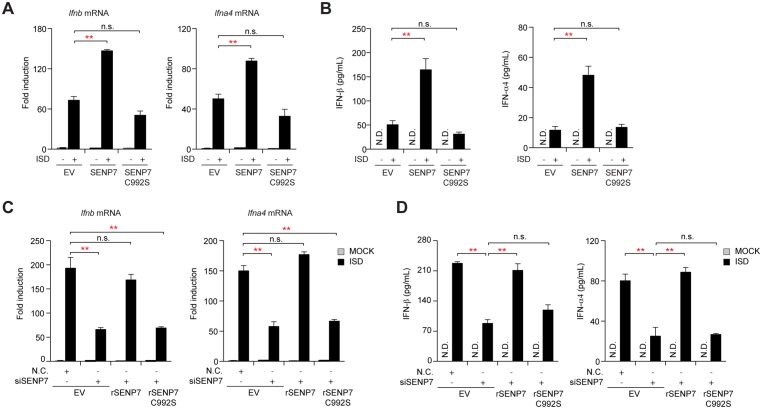
De-SUMOylation activity of SENP7 is essential in potentiating STING signaling.(A) MEFs transfect with empty vector (EV) or vector for the expression of Flag-tagged wild-type SENP7 or SENP7 C992S. Induction of Ifnb and Ifna4 mRNAs was measured by quantitative PCR after ISD stimulation. (B) MEFs were treated as in (A), and the supernatants were collected and assayed for IFN-β and IFN-α4 production by ELISA. (C) MEFs were transfected with the nonspecific control (N.C.) or Senp7 siRNA and then rescued with the indicated siRNA-resistant SENP7 constructs. After ISD stimulation, induction of Ifnb and Ifna4 mRNA was measured by quantitative PCR. (D) MEFs were treated as in (C), and the supernatants were collected and assayed for IFN-β and IFN-α4 production by ELISA. Graphs show the mean ± s.d. and data shown are representative of three independent experiments. n.s., not significant; **P < 0.01 (two-tailed t-test).